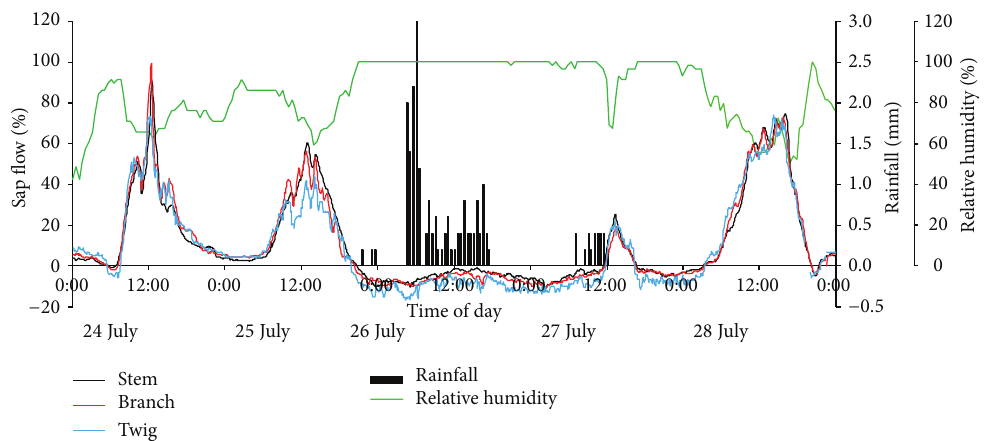
Figure 6: Sap flows at the three different positions on the T. ramosissima plant for the control group during continuous rain events.